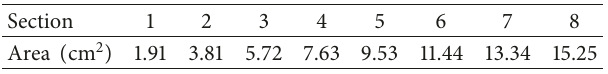
Table 2: Vortex section area.